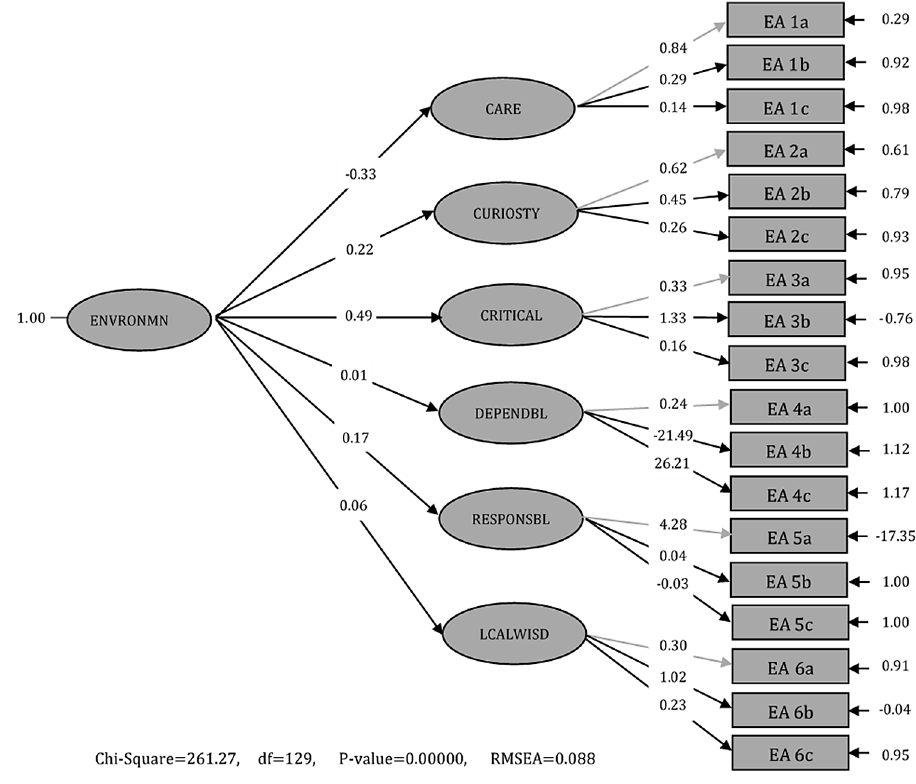
Figure 1. Standard solution second-order confirmatory factor analysis